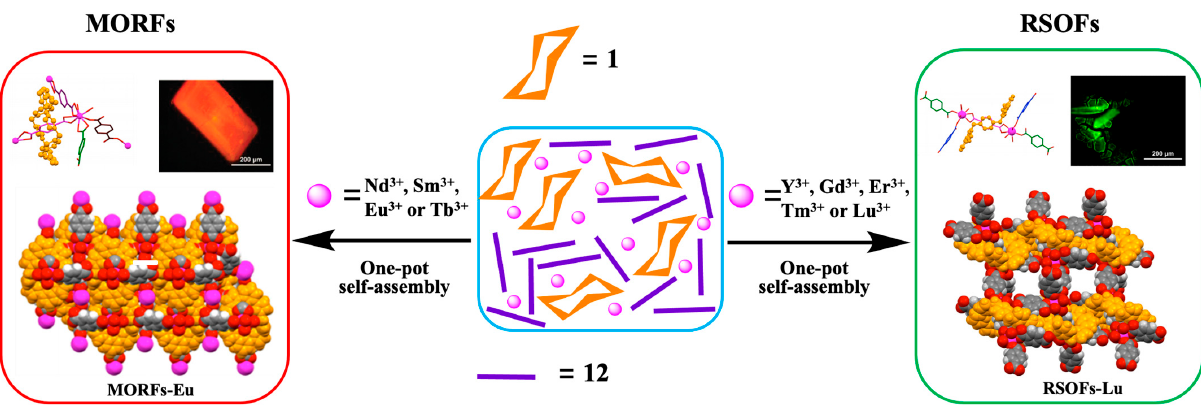
Figure 6. One-pot self-assembly of 3D metal–organic rotaxane frameworks (MORFs and rotaxanated supramolecular organic frameworks (RSOFs) containing the TxSB 1 , the terephthalate dianion and various lanthanide(III) metal cations. Note: Compound numbers are provided in Table 1. Modified with permission from a figure that first appeared in ref. [53]. Copyright 2012 The Royal Society of Chemistry.